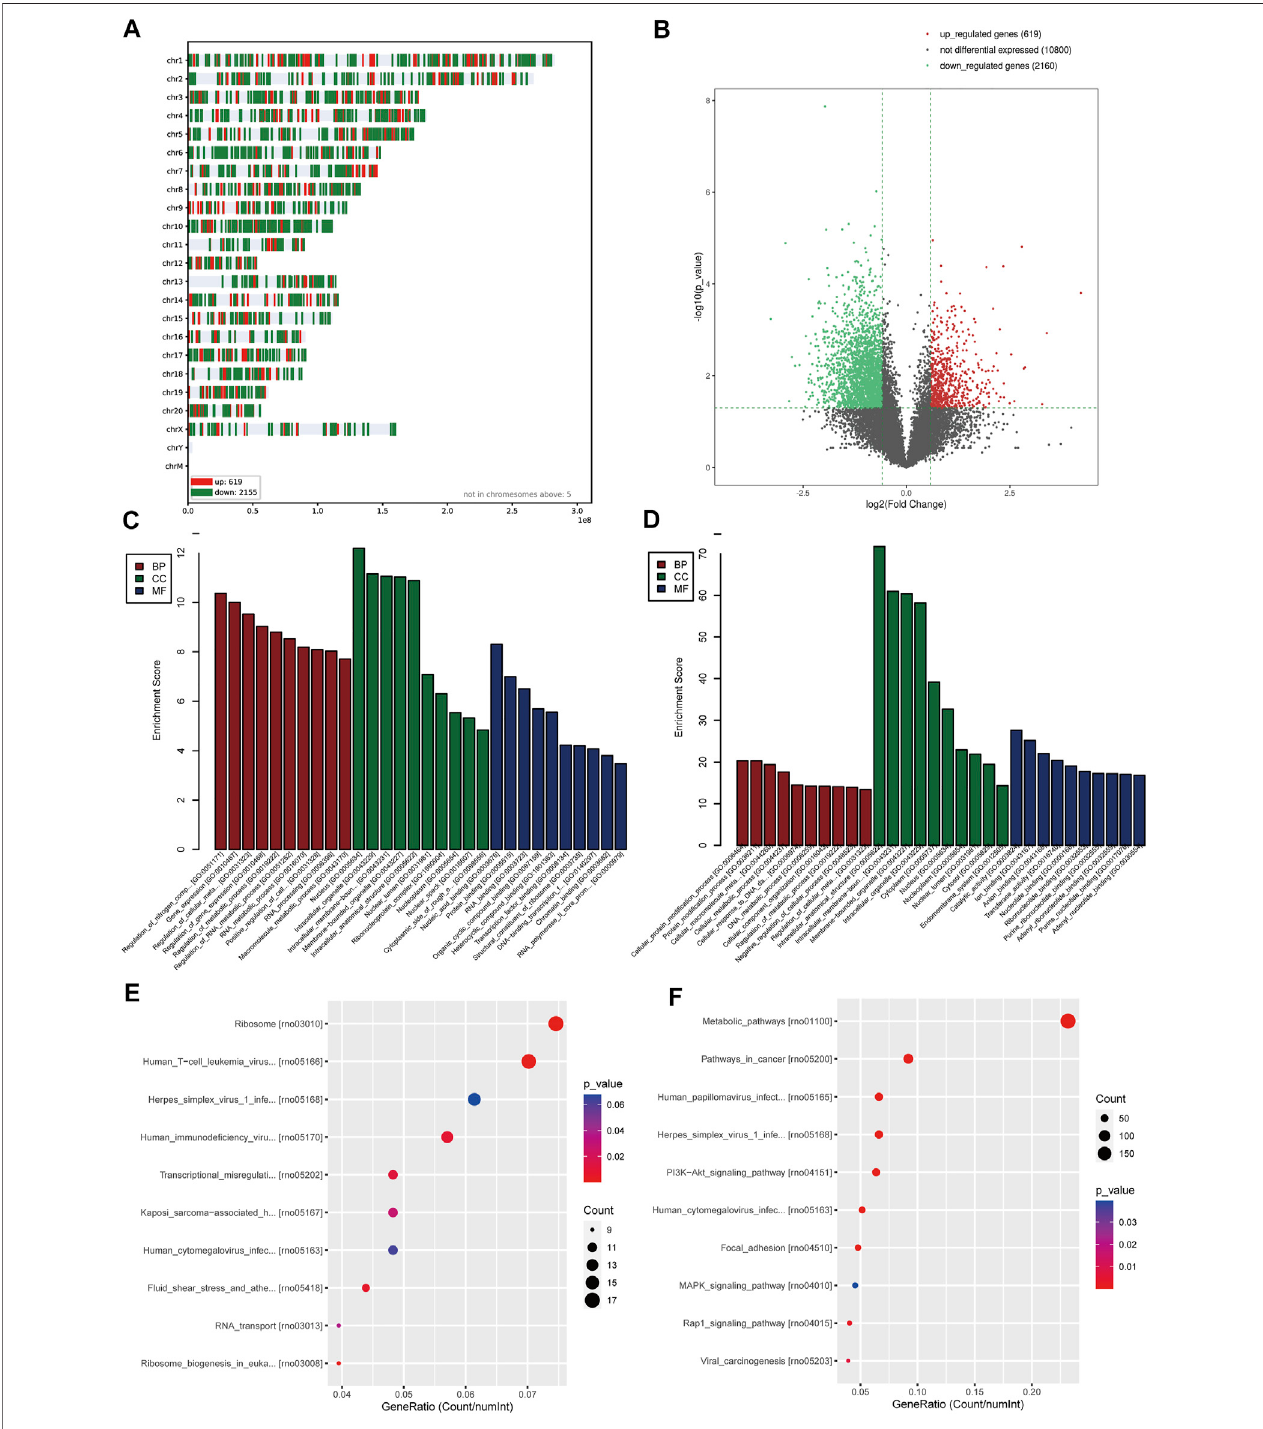
FIGURE5| Analysisofthegeneexpression ofhearttissueofmaternalPHnewbornrats. (A) Thedistribution ofDEGsonchromosomes. (B) Volcano map. Thered points represent upregulated genes selected based on the corrected p-value < 0.05 and logFC > 1.5. The green points represent downregulated genes selected based onthecorrectedp-value < 0.05andlogFC < − 1.5.Theblackpointsrepresentgeneswithnosigni fi cantdifference. (C) GOenrichmentanalysisofupregulatedgenes. (D) GO enrichment analysis of downregulated genes. (E) KEGG pathway analysis of upregulated genes. (F) KEGG pathway analysis of downregulated genes. GO, Gene Ontology; DEGs, differentially expressed genes; KEGG, Kyoto Encyclopedia of Genes and Genomes.